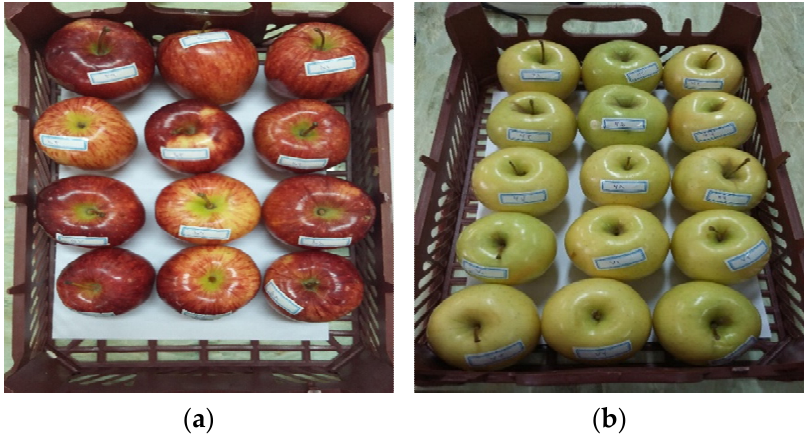
Figure 1. Test samples: ( a ) Red Delicious and ( b ) Golden Delicious.